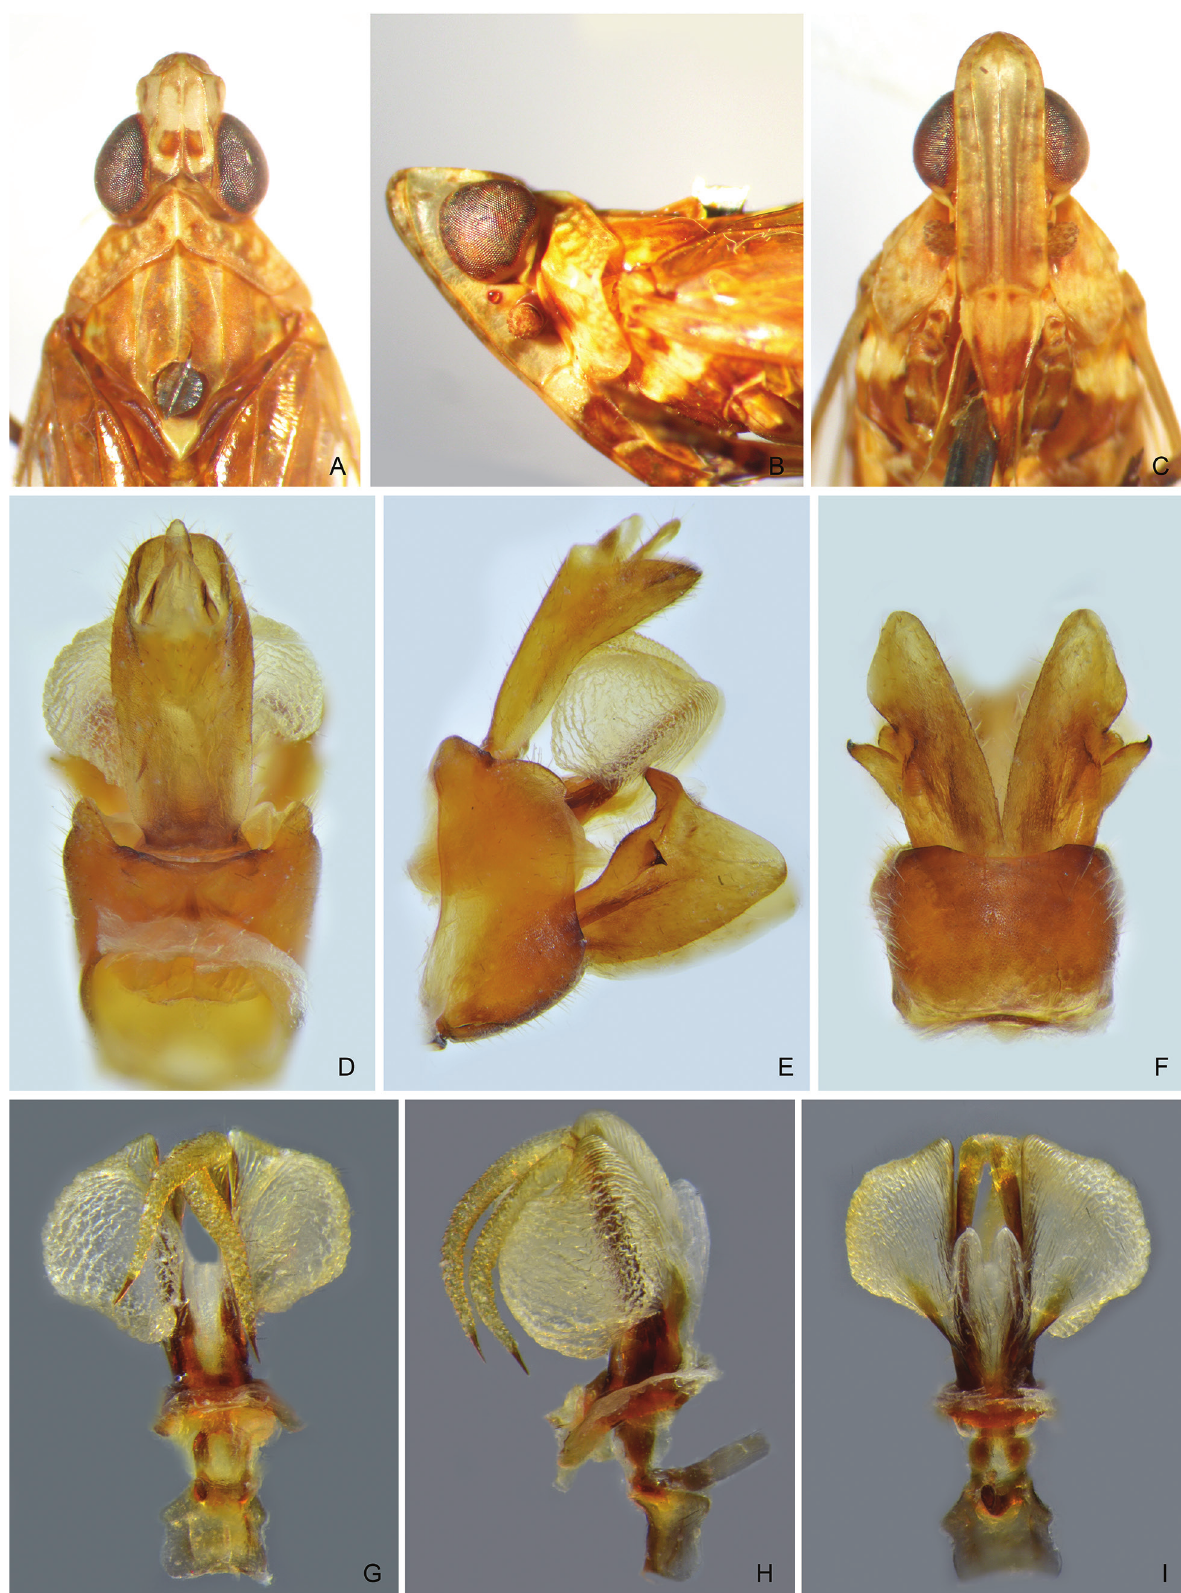
Figure 6. Orthopagus hainanensis sp. n. ( A ) Head, pronotum and mesonotum, dorsal view. ( B ) Head and pronotum, lateral view. ( C ) Head and pronotum, ventral view. ( D ) Male segment X and pygofer, dorsal view. ( E ) Male pygofer, gonostyles, and segment X, lateral view. ( F ) Male pygofer and gonostyles, ventral view. ( G ) Aedeagus, dorsal view. ( H ) Aedeagus, lateral view. ( I ) Aedea- gus, ventral